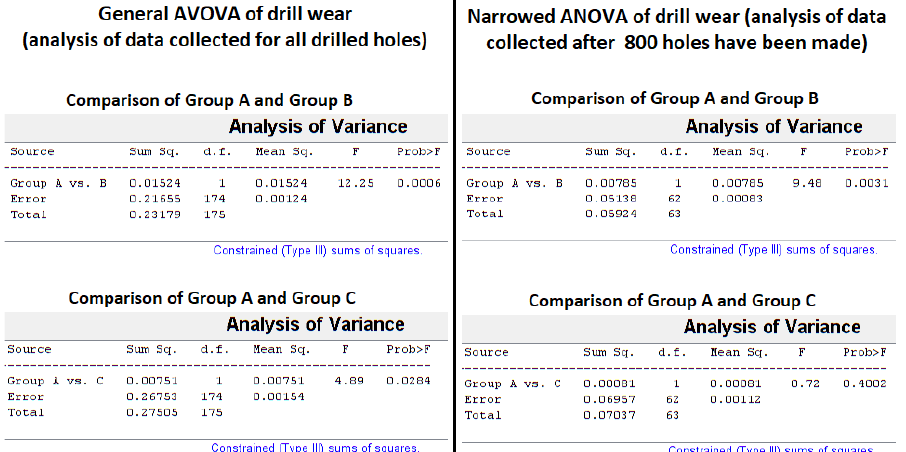
Figure 16. The detailed results of all ANOVA tests carried out in the study.